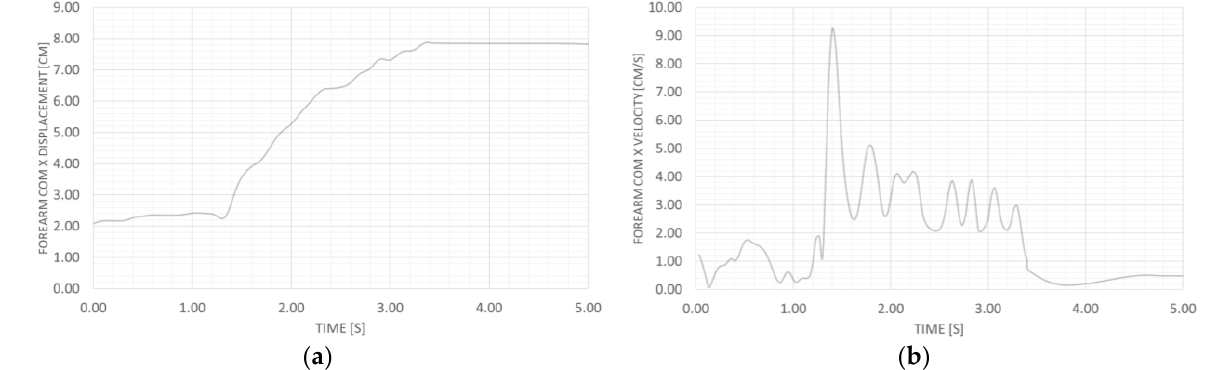
Figure 16. Forearm experimental test results: ( a ) Linear displacement, ( b ) Linear velocities.